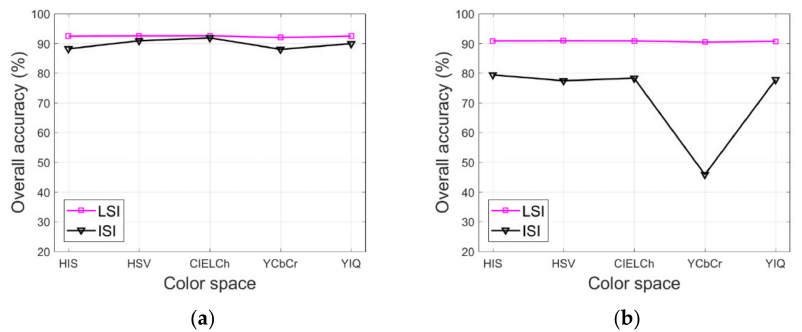
Figure 8. Overall accuracies of shadow detection results with the initial shadow index and the logarithmic shadow index for test images. ( a ) Tripoli-1. ( b )